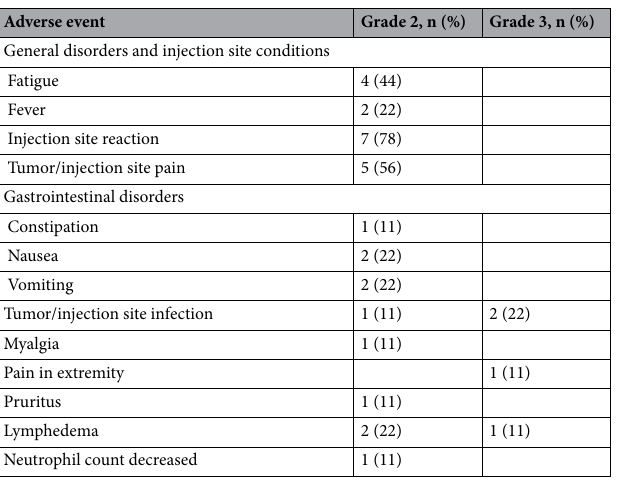
Table 2. Grade 2 or higher adverse events possibly, probably, or definitely related to T-VEC.